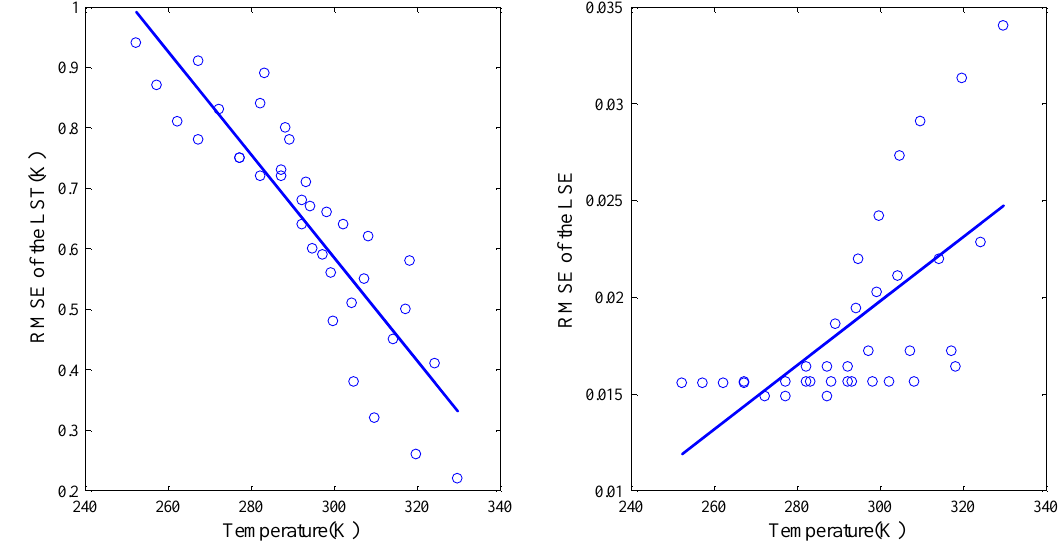
Figure 7. The RMSE of LST and LSE according to different temperatures.